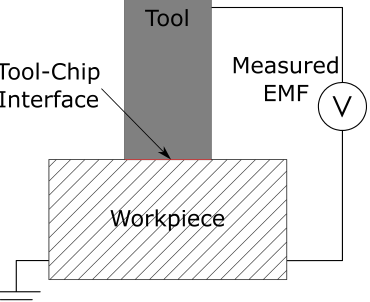
Figure 3. Simplified tool–workpiece thermocouple circuit, based on Stephenson